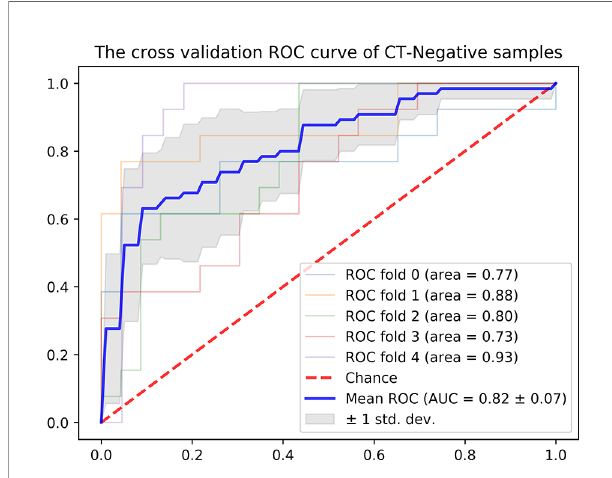
FIGURE 5 | ROC curve of the radiomics nomogram in the CT-reported LN- negative samples by fi ve-fold